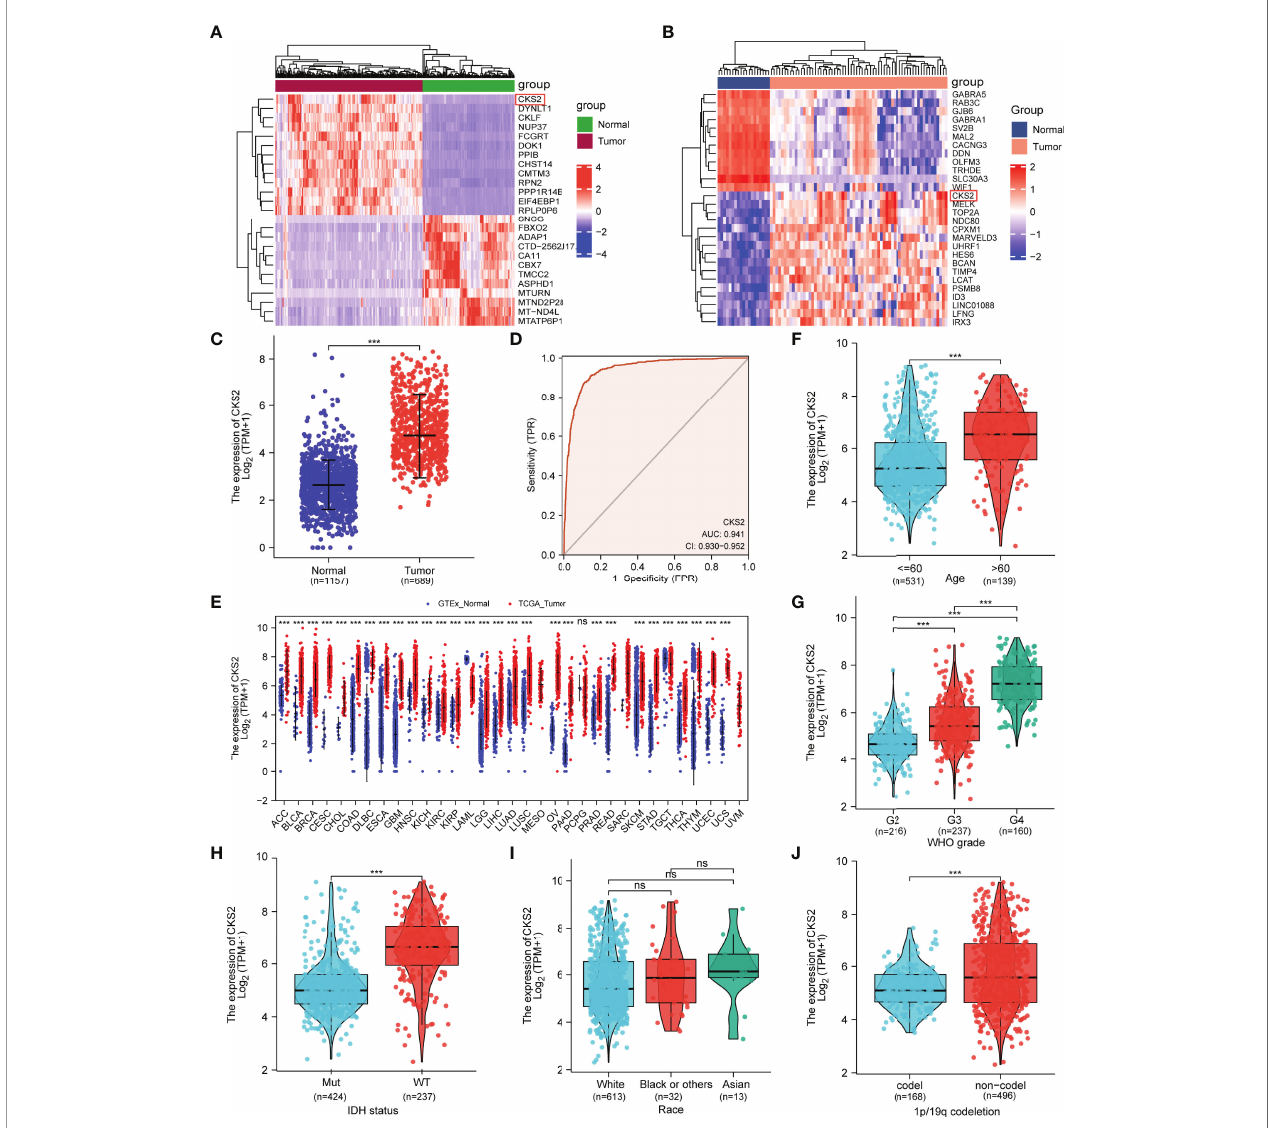
FIGURE 1 | Analysis of CKS2 mRNA expression in glioma and other human cancers in TCGA and GEO databases. (A, B) Heatmaps of CKS2 expression levels in the (A) GSE4290 and (B) TCGA datasets. (C) Expression levels of CKS2 in glioma (n = 689) and normal tissue (n= 1157). (D) Receiver operating characteristic (ROC) analysis of CKS2 in glioma samples (n = 689). (E) CKS2 expression levels in various cancers from TCGA database. (F) Association between CKS2 expression and age (n = 613). (G) Association between CKS2 expression and histological grade (n = 613). (H) Association between CKS2 expression and IDH mutation status (n = 661). (I) Association between CKS2 expression and race (n = 613). (J) CKS2 expression in 1p/19q co-deletion codel and non-codel (n = 664) (*** p < 0.001). NS, not signi fi